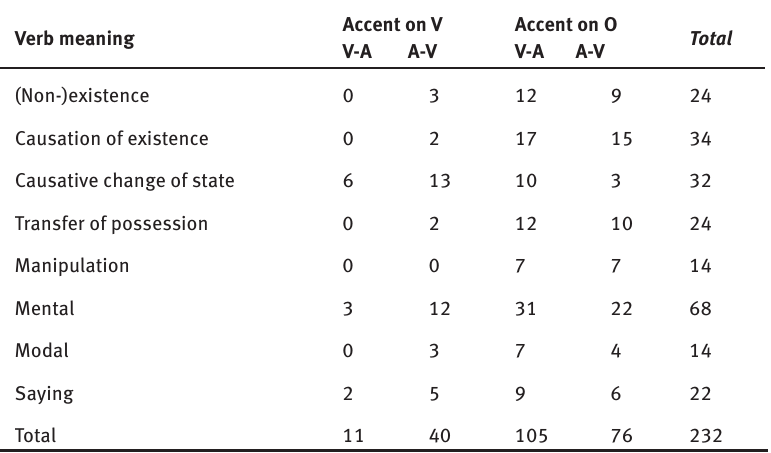
Table 6. The distribution of the perceptually identified nuclear accents with respect to verb